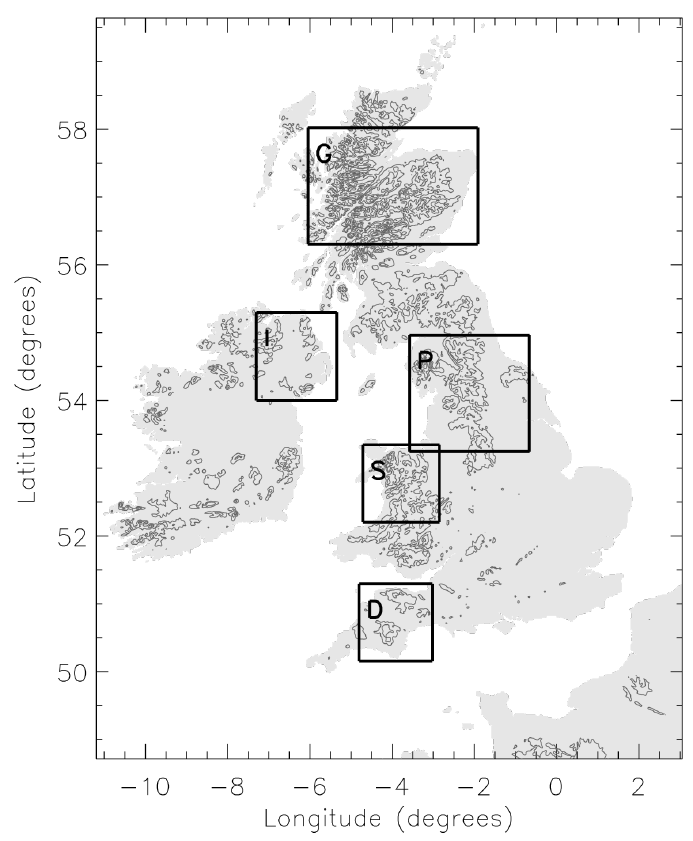
Figure 1. The location of the operational 3D velocities over mountains (3DVOM) forecast domains over the U.K. The labels ‘G’, ‘I’, ‘P’, ‘S’ and ‘D’ refer to the Grampians, Northern Ireland, Pennines, Snowdonia and Dartmoor domains, respectively. Also shown are terrain height contours (line contours) at an interval of 200